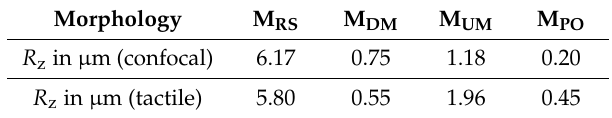
Figure 4. Topographies of the investigated morphologies: ( a ) confocal image M RS ; ( b ) Secondary electron (SE)image M RS ; ( c ) confocal image M DM ; ( d ) SE image M DM with traces of the down milling process; ( e ) confocal image M UM ; ( f ) SE image M UM ; ( g ) confocal image M PO ; ( h ) SE image M PO . Table 4. Mean roughness ( R z ) in µ m of the investigated surface